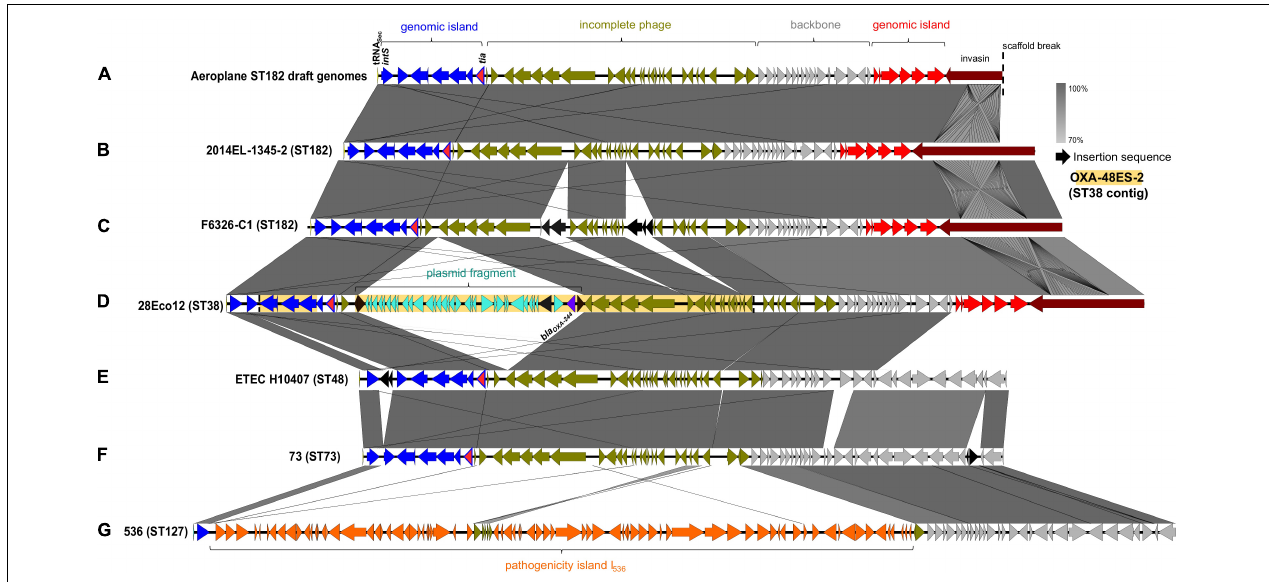
FIGURE 6 | Invasin-enriched region containing tia . (A) Region represented in isolates from this collection. (B) Region located E. coli ST182 strain 2014EL-1345-2 (CP024223.1, location: 2157800 – 2225307). (C) Region located in E. coli ST182 strain F6326-C1 (CP024263.1, location: 3353753 – 3426635). (D) Region in E. coli ST38 strain 28Eco12 shown in reversed orientation (CP038505.1, location: 48178 – 136524). Shaded yellow region represents genes present a sequenced E. coli ST38 contig (KT444705.1). The full contig is represented, which lacks four genes present in 28Eco12, including tia , and has no additional genes. (E) Region in E. coli ST48 (CC10) strain ETEC H10407 (FN69414.1, location: 4215539 – 4277567). (F) Region in E. coli ST73 strain 73 shown in reverse (CP041538.1, location: 1778685 – 1839792). (G) Region in E. coli ST127 strain 536 (CP000247.1, location 3947789 – 4041729). Image created using EasyFig.